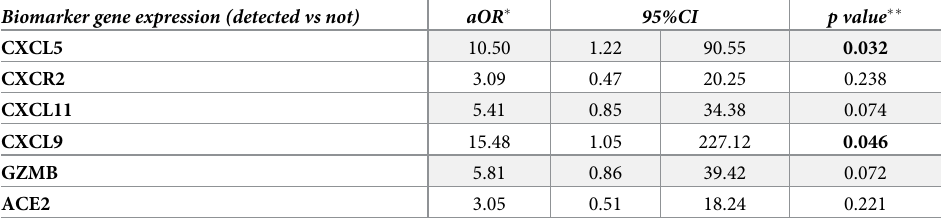
Table 4. Multivariate analysis assessing the prognostic value of biomarker gene expression on 30-day mortality in ICU patients (N = 44, 17 deaths). Biomarker gene expression (detected vs not) aOR �